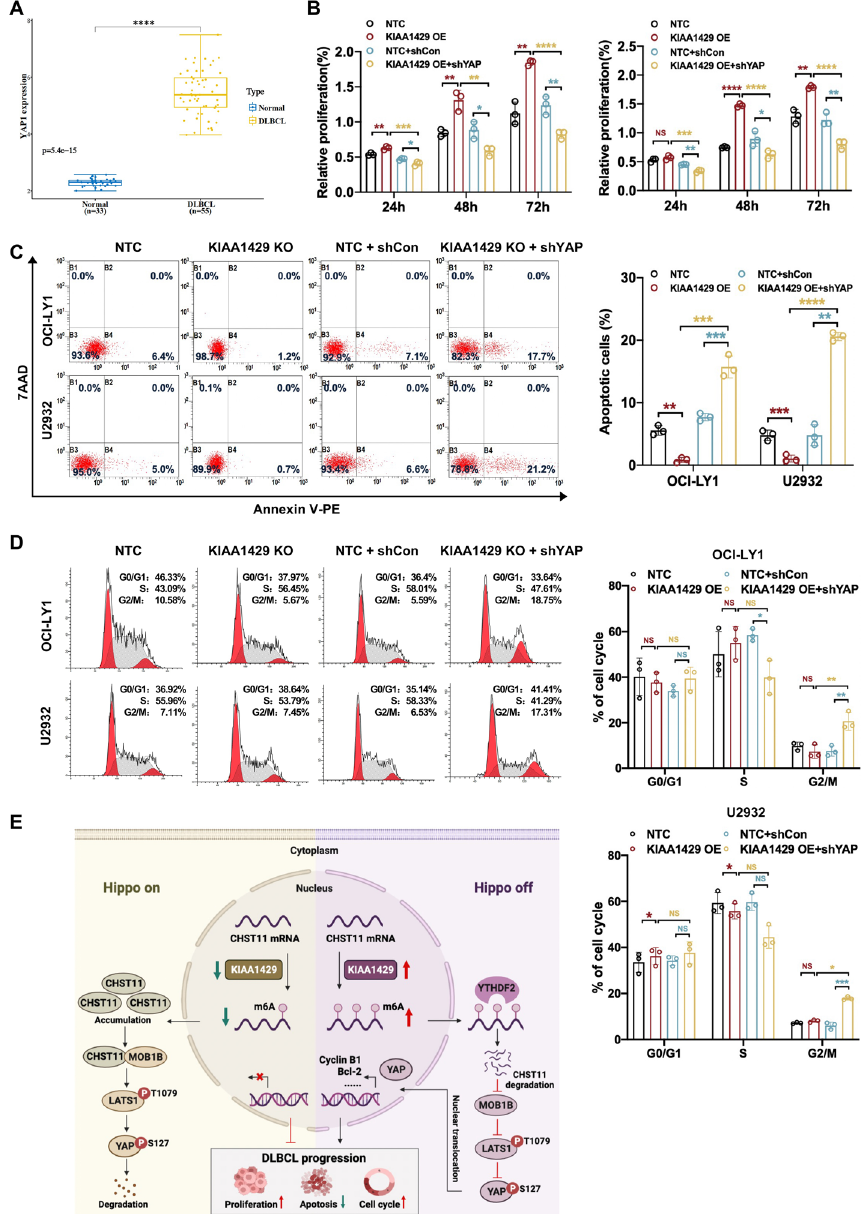
Fig. 8 KIAA1429 inactivated Hippo–YAP signaling by interacting with CHST11. A YAP was highly expressed in DLBCL tissues ( n 55) compared with healthy tonsil tissues ( n 33) based on the GSE56315 dataset. B – D = = Knockdown of YAP inhibited cell proliferation promotion, apoptosis reduction, and cell cycle progression acceleration induced by KIAA1429 overexpression. Mean SD is presented for three independent ± experiments. * p < 0.05, ** p < 0.01; *** p < 0.001; **** p < 0.0001. E Model of KIAA1429-mediated m6A modification regulating DLBCL progression through the Hippo–YAP